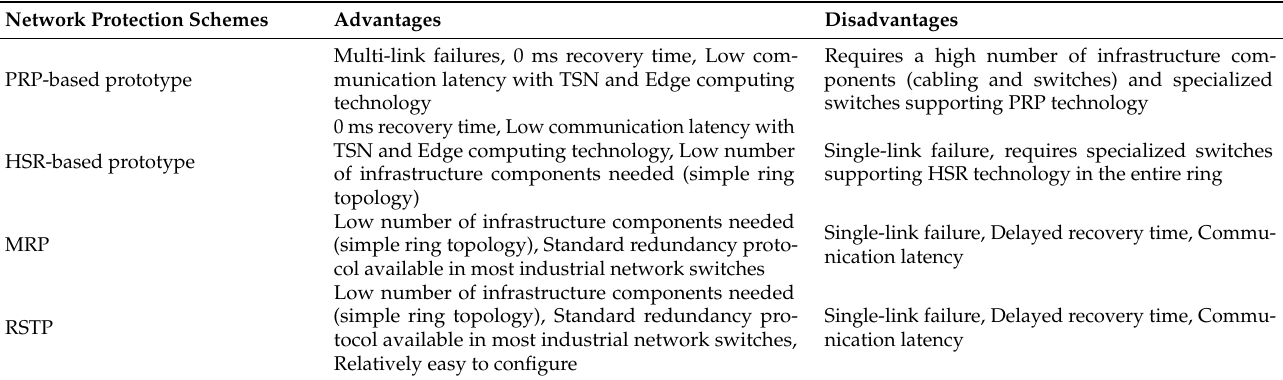
Table 3. Proposed network communication prototypes versus standalone redundancy